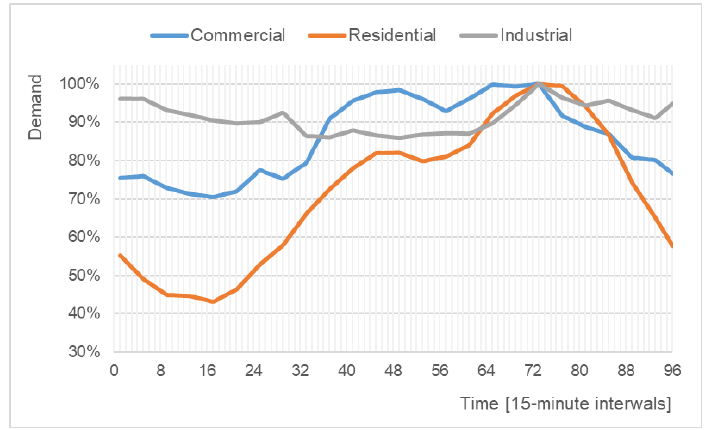
Figure 7. Demand profiles for commercial, residential and industrial passive loads (own development based on [28]).